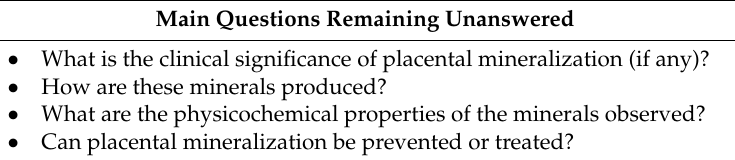
Table 7. List of main questions that remain unanswered in relation to placental calcification. Main Questions Remaining Unanswered